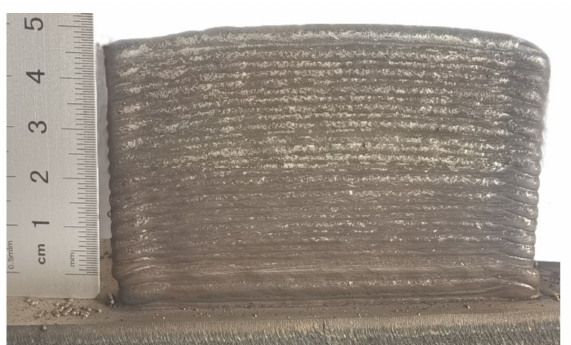
Figure 3. Macroscopic morphology of SS 321 fabricated by